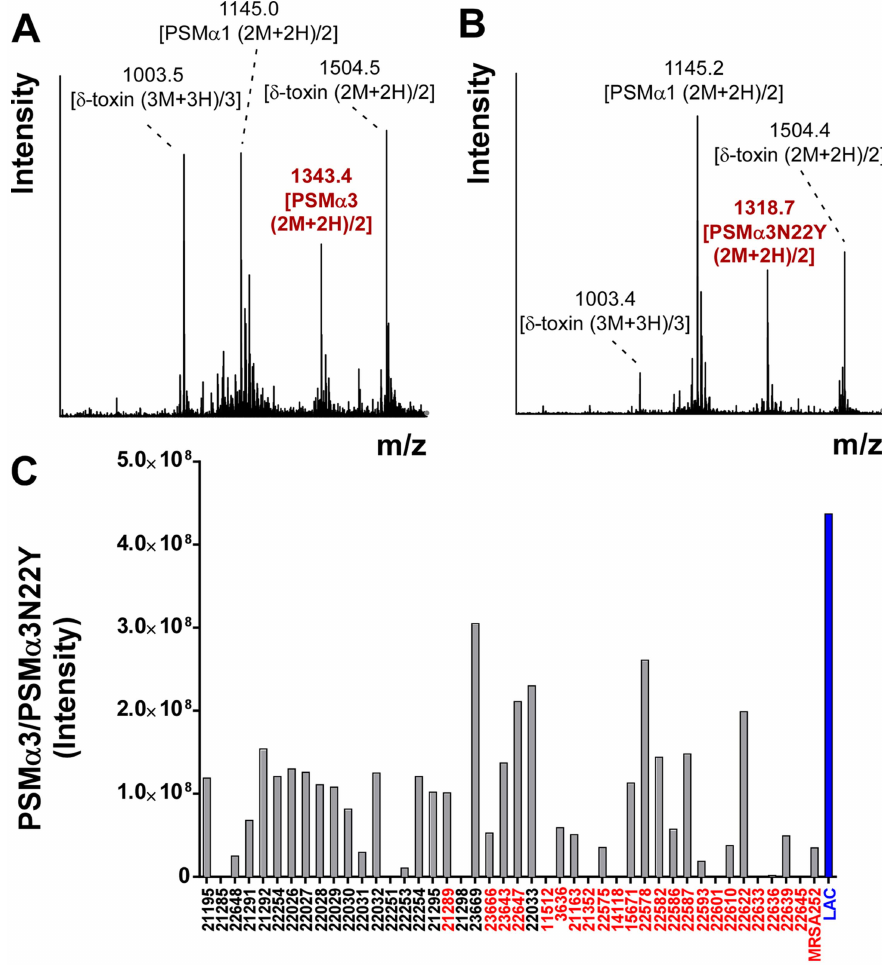
Figure 1. CC30 strains produce a variant of PSM a 3. (A,B) Mass spectrogram of the region where PSM a 3 elutes during RP-HPLC/MS of the culture filtrate of a non-CC30 strain (USA300) (A) or a CC30 strain (B), respectively. The peak corresponding to PSM a 3 is marked in red. Other peaks are from co-eluting PSM peptides. (C) PSM a 3N22Y production in a collection of historic and contemporary CC30 strains. Strains shown in red contain a mutation in agrC that is characteristic of contemporary CC30 strains. Production of PSM a 3 in strain LAC (USA300) is shown as